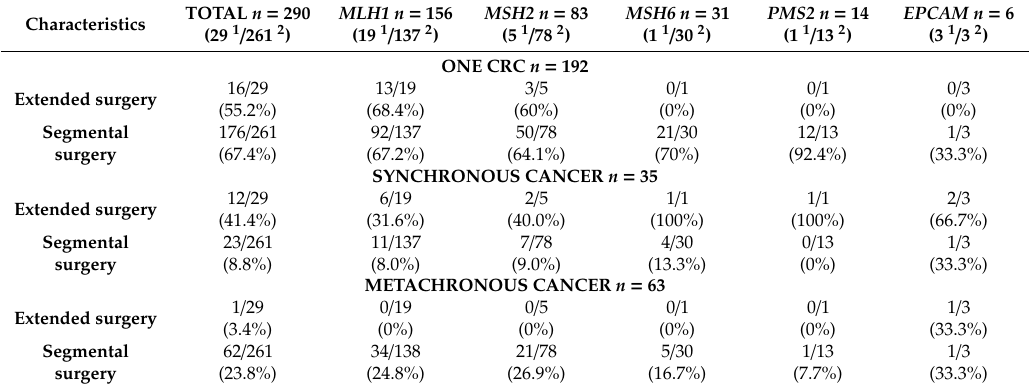
Table 3. Number of second colorectal cancer according to mutated gene and type of surgery performed.